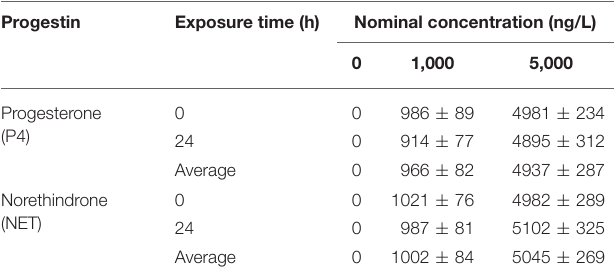
TABLE 7 | The nominal and measured progestin levels in the zebrafish exposure experiments.